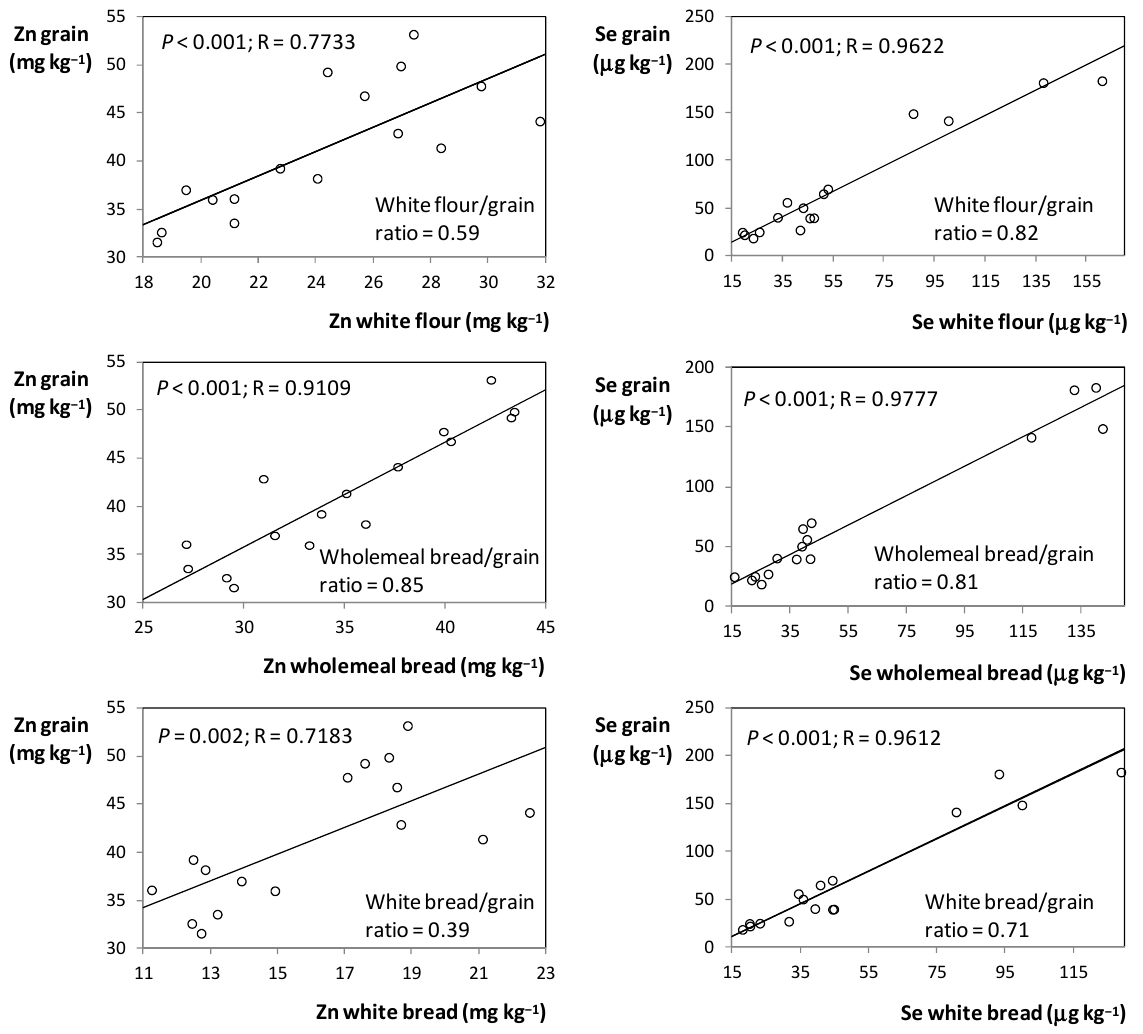
Figure 2. Relationship between Zn ( left ) or Se ( right ) in grain and their concentrations in white flour, wholemeal bread and white bread. The ratio between either, Zn or Se in grain and the concentration in white flour, wholemeal bread or white bread, respectively, is presented in the lower right corner. R: Pearson´s correlation coefficient.